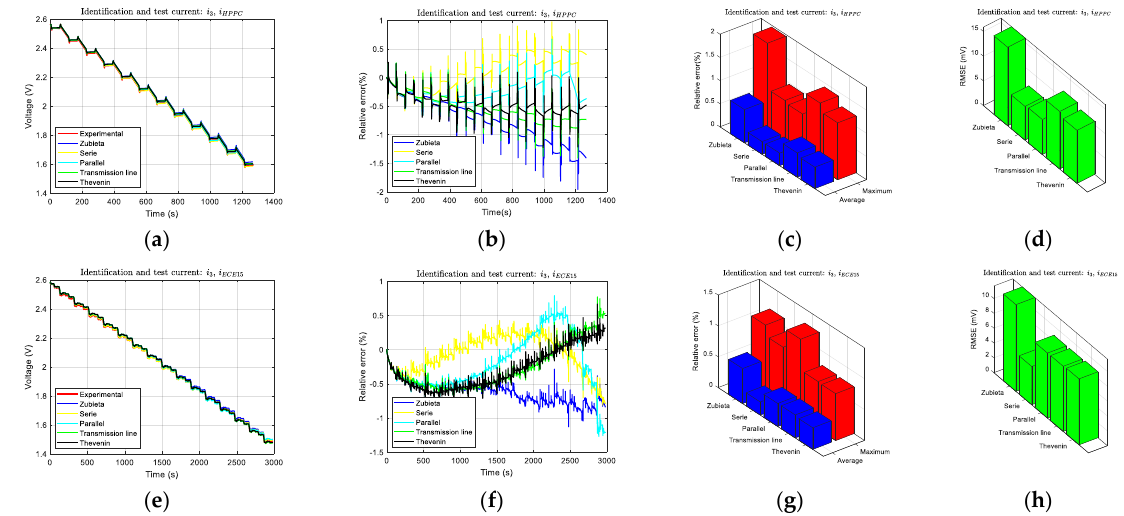
Figure 13. Experimental data and supercapacitor models time response, relative error (%), RMS error (mV): ( a ) – ( d ) current profile HPPC for i 3 , ( e ) – ( h ) current profile ECE15 for i 3 .